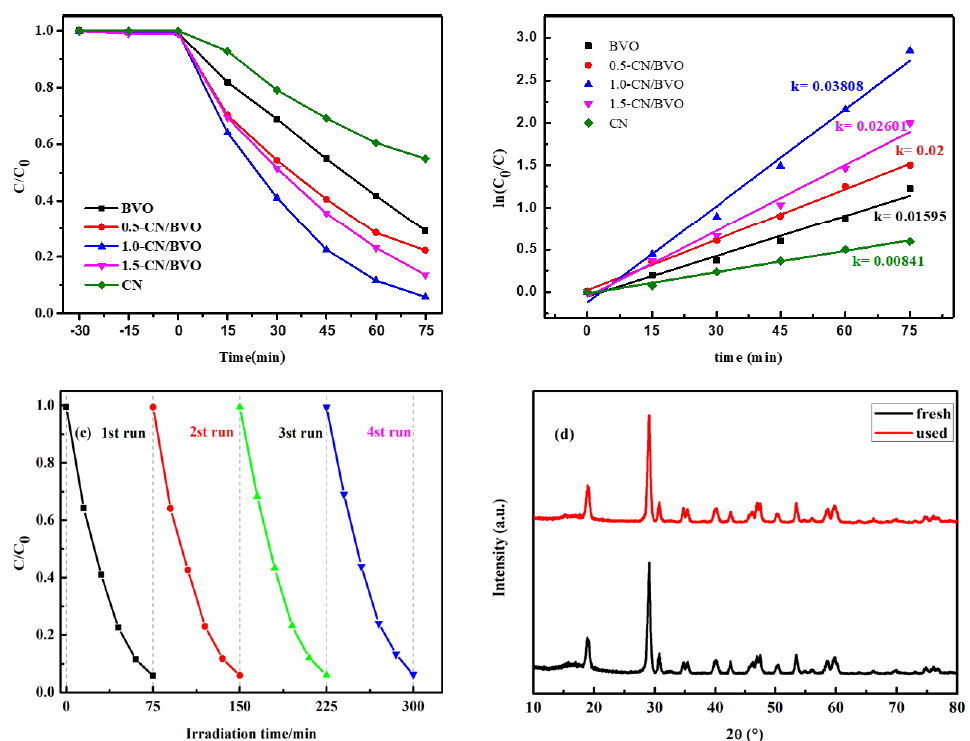
Figure 5. The removal efficiency of MB as a function of irradiation time and corresponding ln ( C 0 /C ) curves of as-prepared ( a , b ); ( c ) cyclic test of photocatalytic degradation of MB by 1.0-CN/BVO. ( d ) XRD patterns of fresh and used 1.0-CN/BVO.